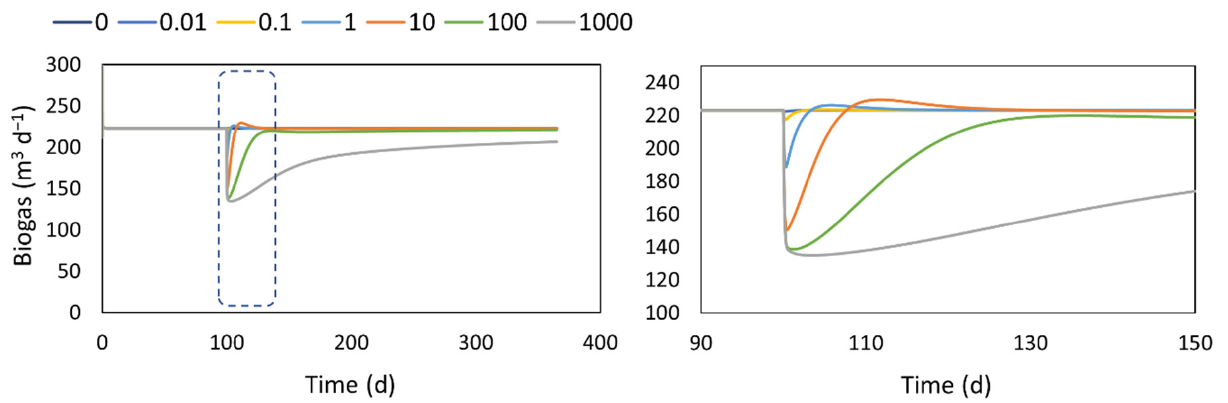
Figure 5. Performance of a digester during the adaptation to a co-substrate addition with different substrate characteristics. Left : results of a year of operation. Right : zoom in on the first 50 days of operation.